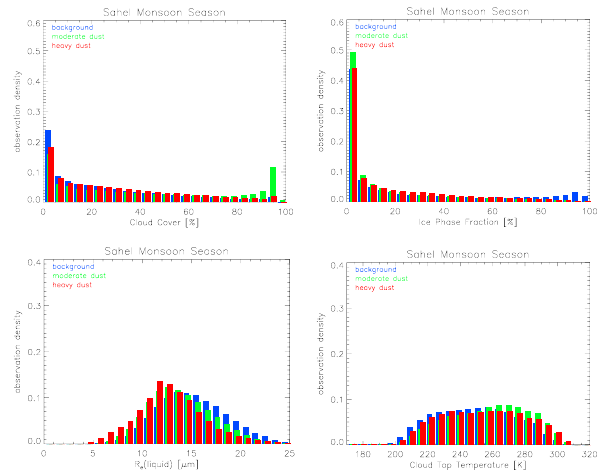
Fig. 3. Histograms of MODIS cloud cover (top left), ice phase frac- tion (top right), liquid cloud effective radii (bottom left) and cloud top temperature (bottom right) for no, moderate and heavy min- eral dust AOD load (blue, green and red, respectively). These his- tograms show the shape of the overall distributions during the wet (monsoon) season and are not separated by air